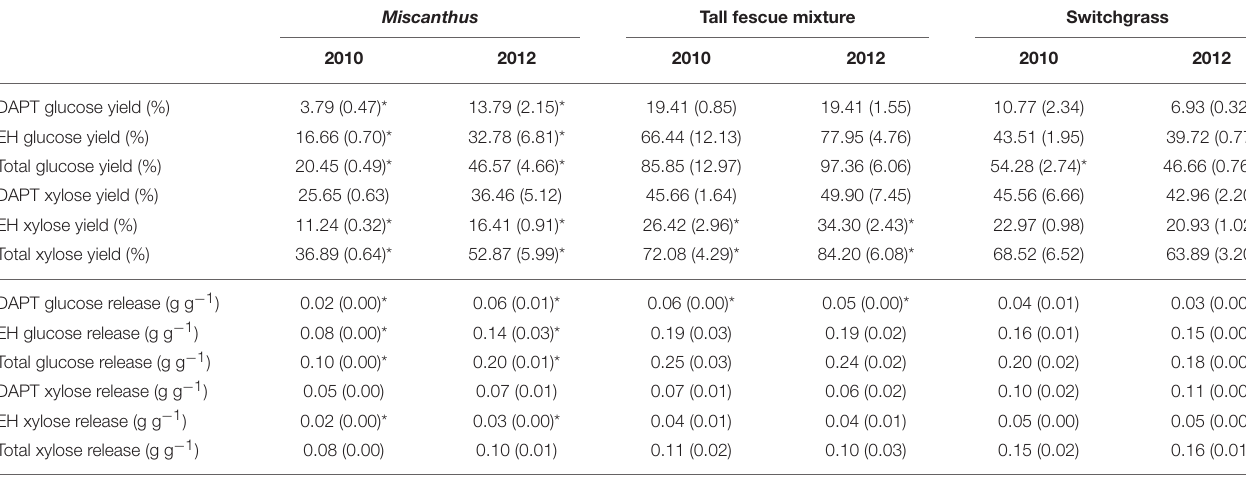
TABLE 4 | Glucose and xylose yield (%) and release (grams per gram dry biomass) from dilute-acid pretreatment (DAPT), enzymatic hydrolysis (EH), and both DAPT and EH (total) for Miscanthus , the tall fescue mixture, and switchgrass grown in 2010 and 2012 [ n = 3; mean (1 SD )].